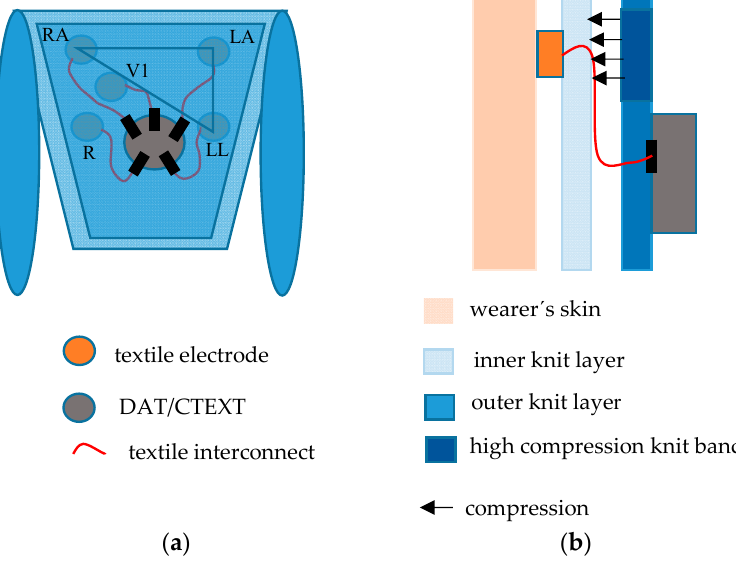
Figure 1. Schematics of T-shirt embedding textile sensors, textile interconnectors and either a custom DAT unit or terminals for electrical connection to an external data acquisition unit; ( a ) front-view representation; and ( b ) cross-section representation.